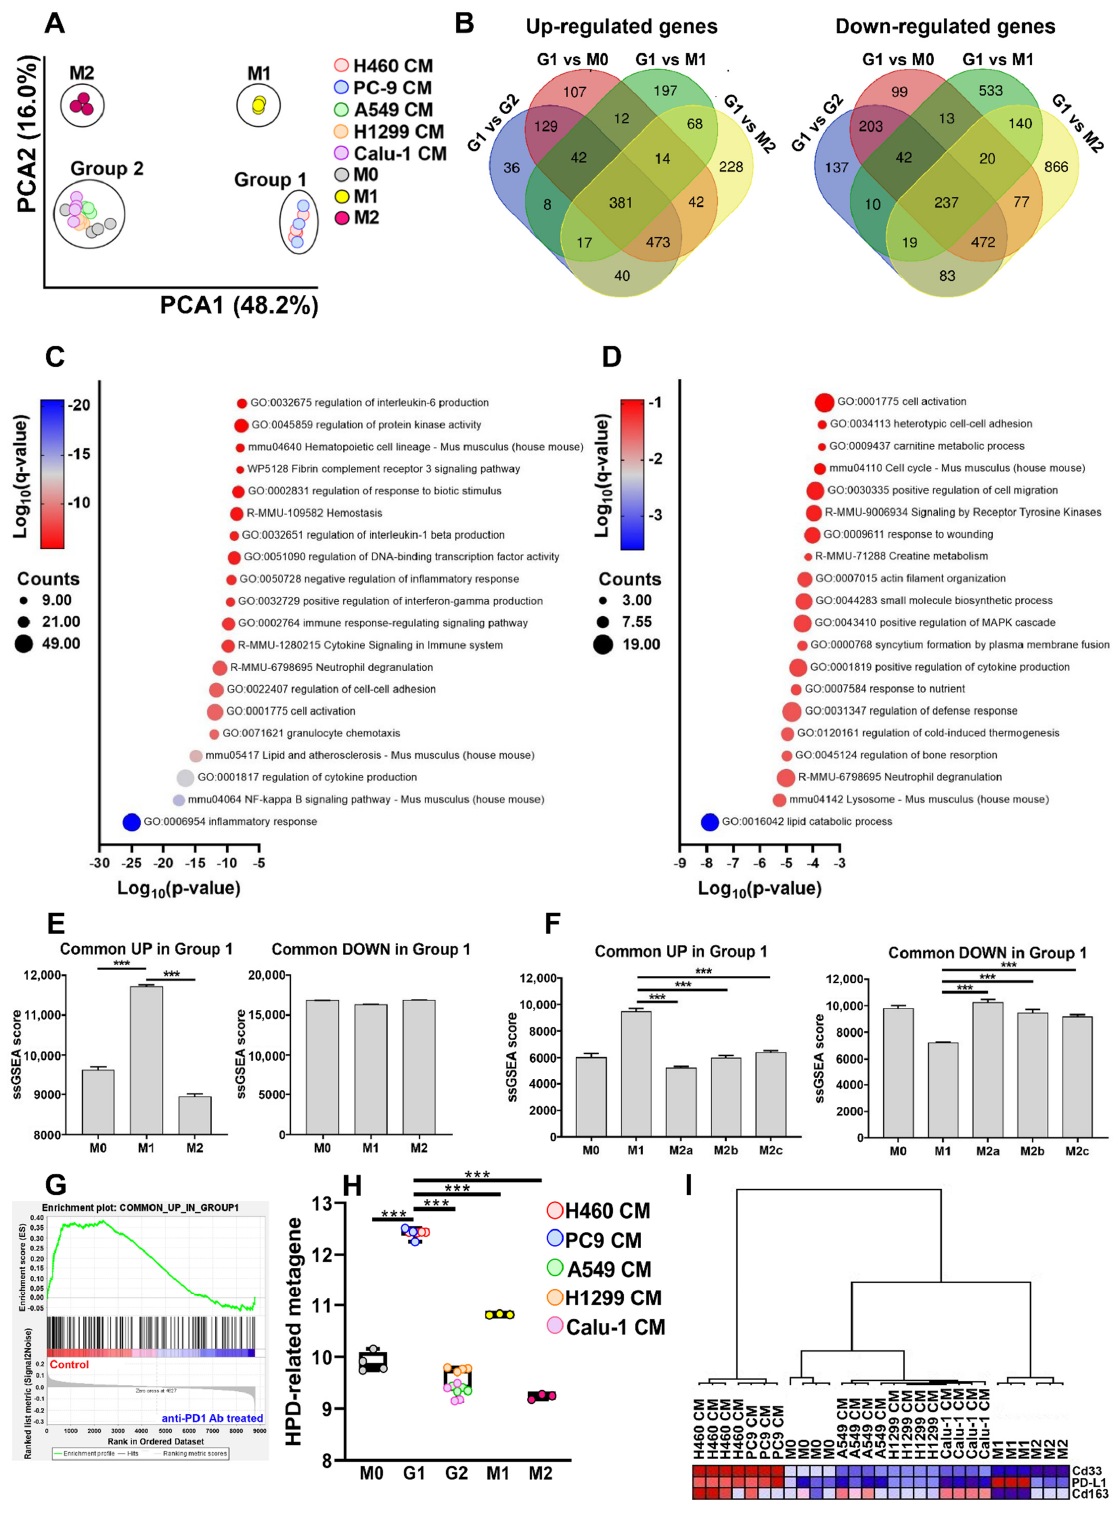
Figure 5. Analysis of NSCLC cell-mediated polarization skewing of BMDMs by bioinformatic analysis. ( A ) Global representation of normalized gene expression profile data of M0 (unstimulated), M1 (LPS + IFN- γ ), M2 (IL-4) and NSCLC cell CM-stimulated macrophages by PCA. Each dot represents a sample. ( B ) Venn diagram showing the overlap between up- or down-modulated DEGs (FDR<0.01and − 2 ≤ FC ≥ 2)emerged by comparing Group 1 to M0, M1, M2 and Group 2